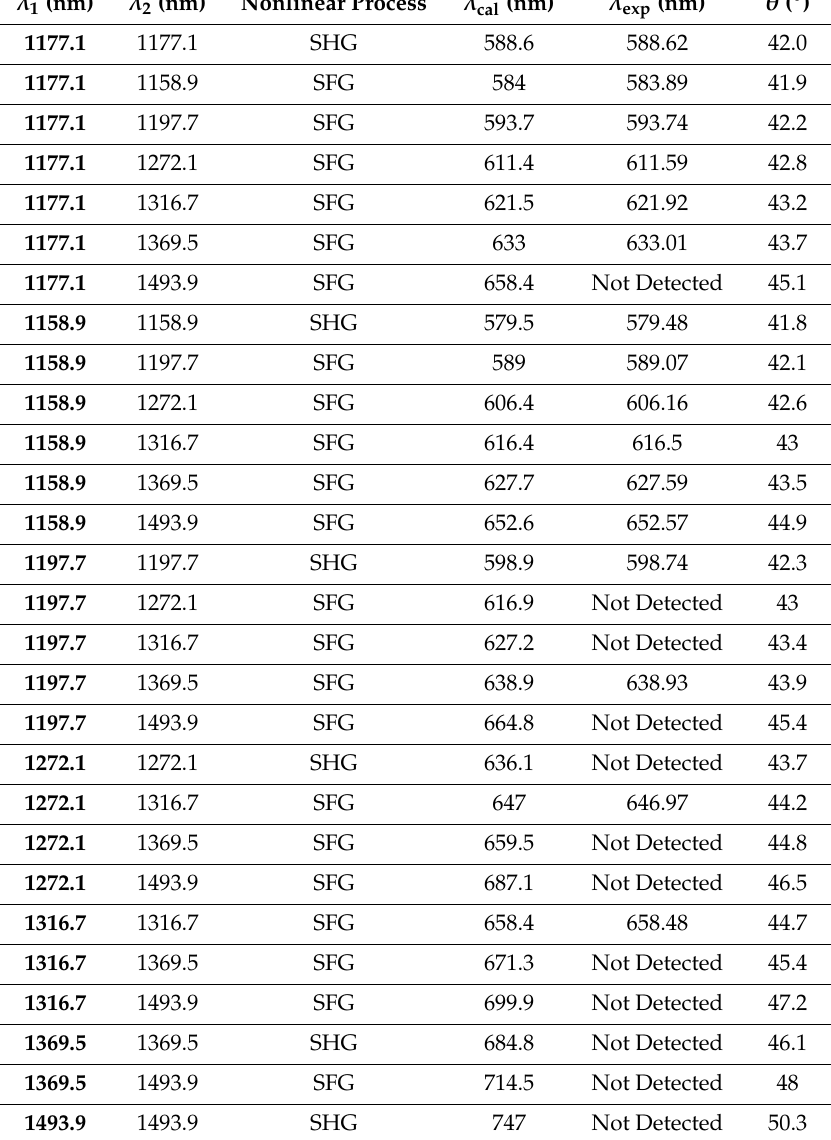
Table 1. Calculated and measured output wavelengths with di ff erent phase-matching